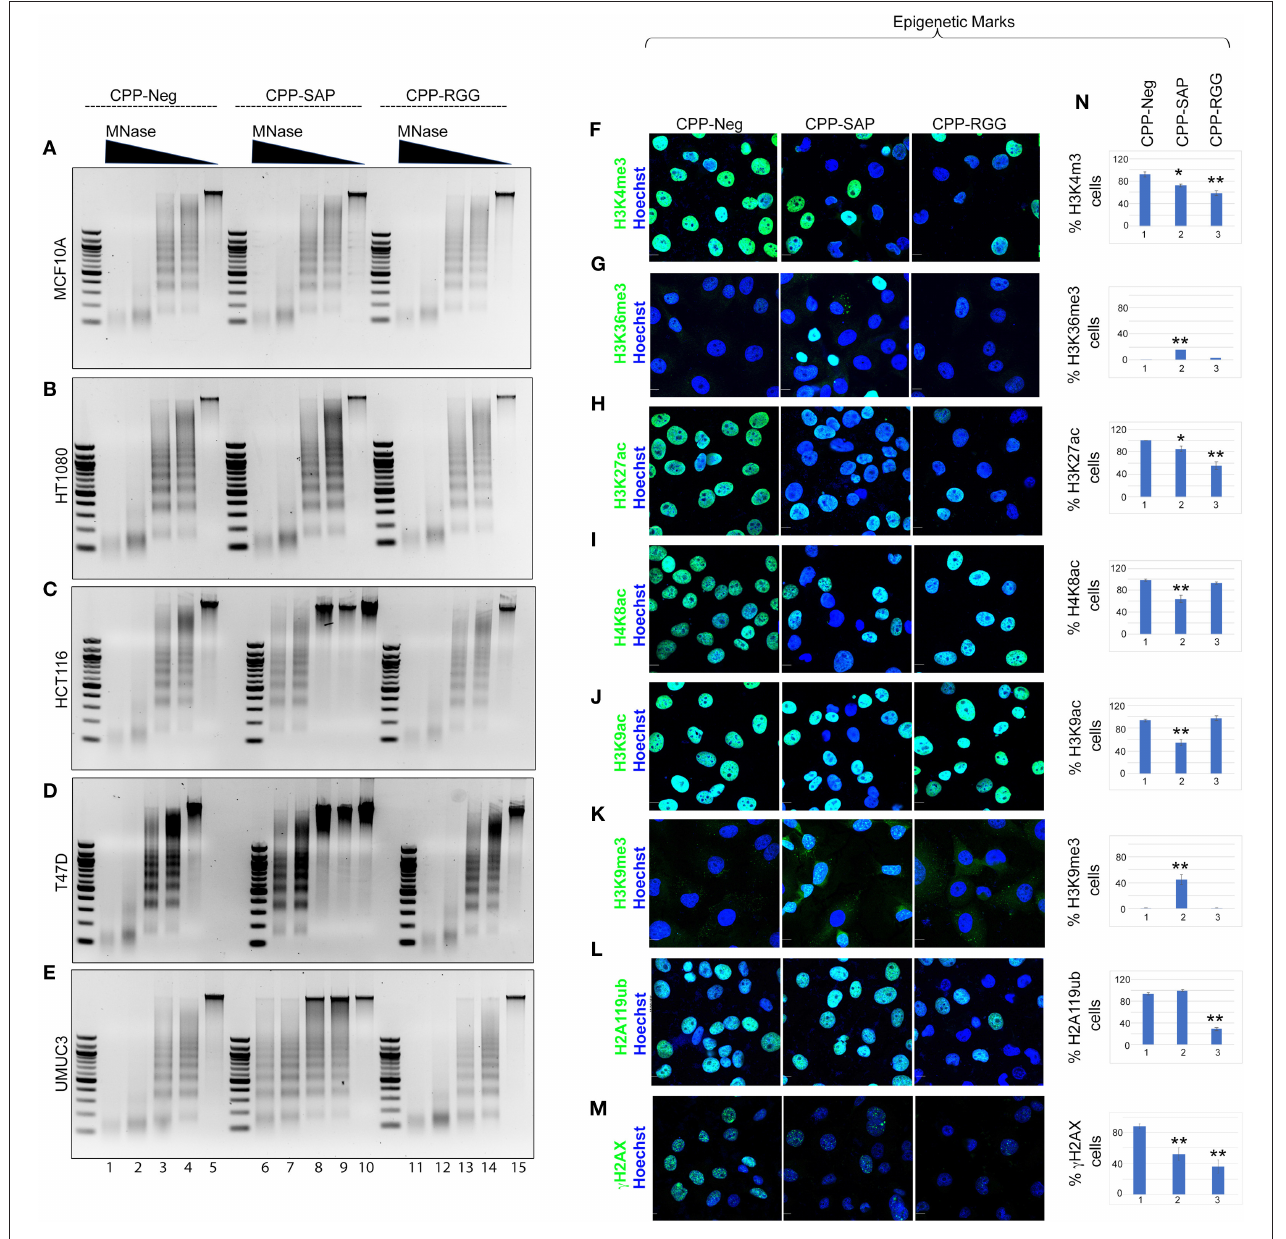
FIGURE 7 | CPP-RGG and CPP-SAP alter chromatin organization and epigenetic marks in HCT116 cells. (A–E) Agarose gel images of MNase digested chromatin from cells pretreated with SAFA-derived peptides for 24h. Relative MNase concentration gradient at top. (F–M) Immunofluorescence analysis of histone marks in treated HCT116 cells. Scale bar, 10 µ m. (N) Quantification of % cells positive for the indicated histone epigenetic marks in response to peptide treatment. * p < 0.05, ** p < 0.01 relative to